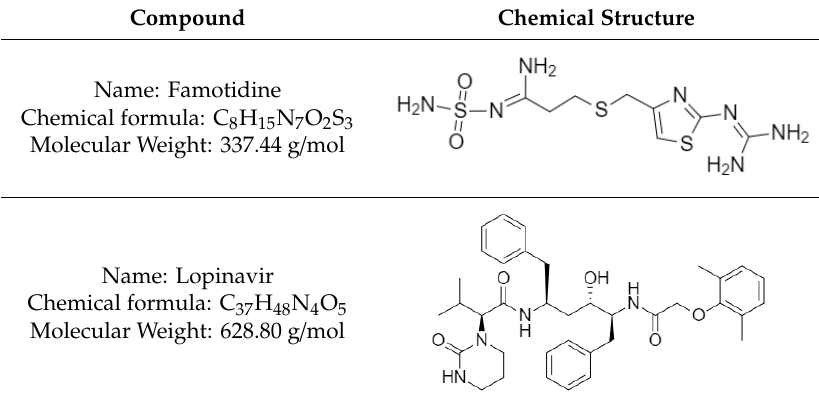
Table 1. Chemical structure of the compounds evaluated as protease inhibitors.